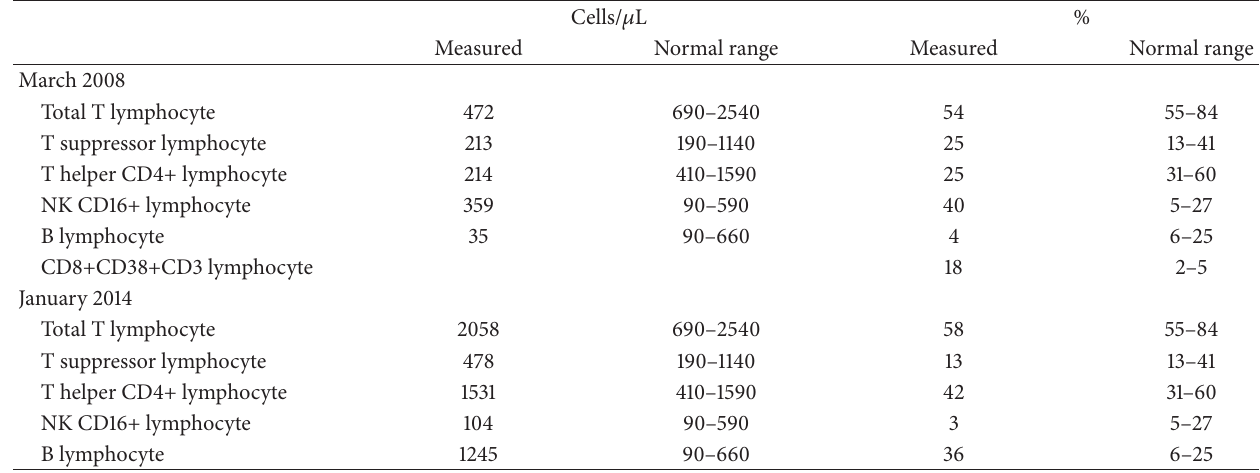
Table 2: Lymphocyte typing of March 2008, before steroids